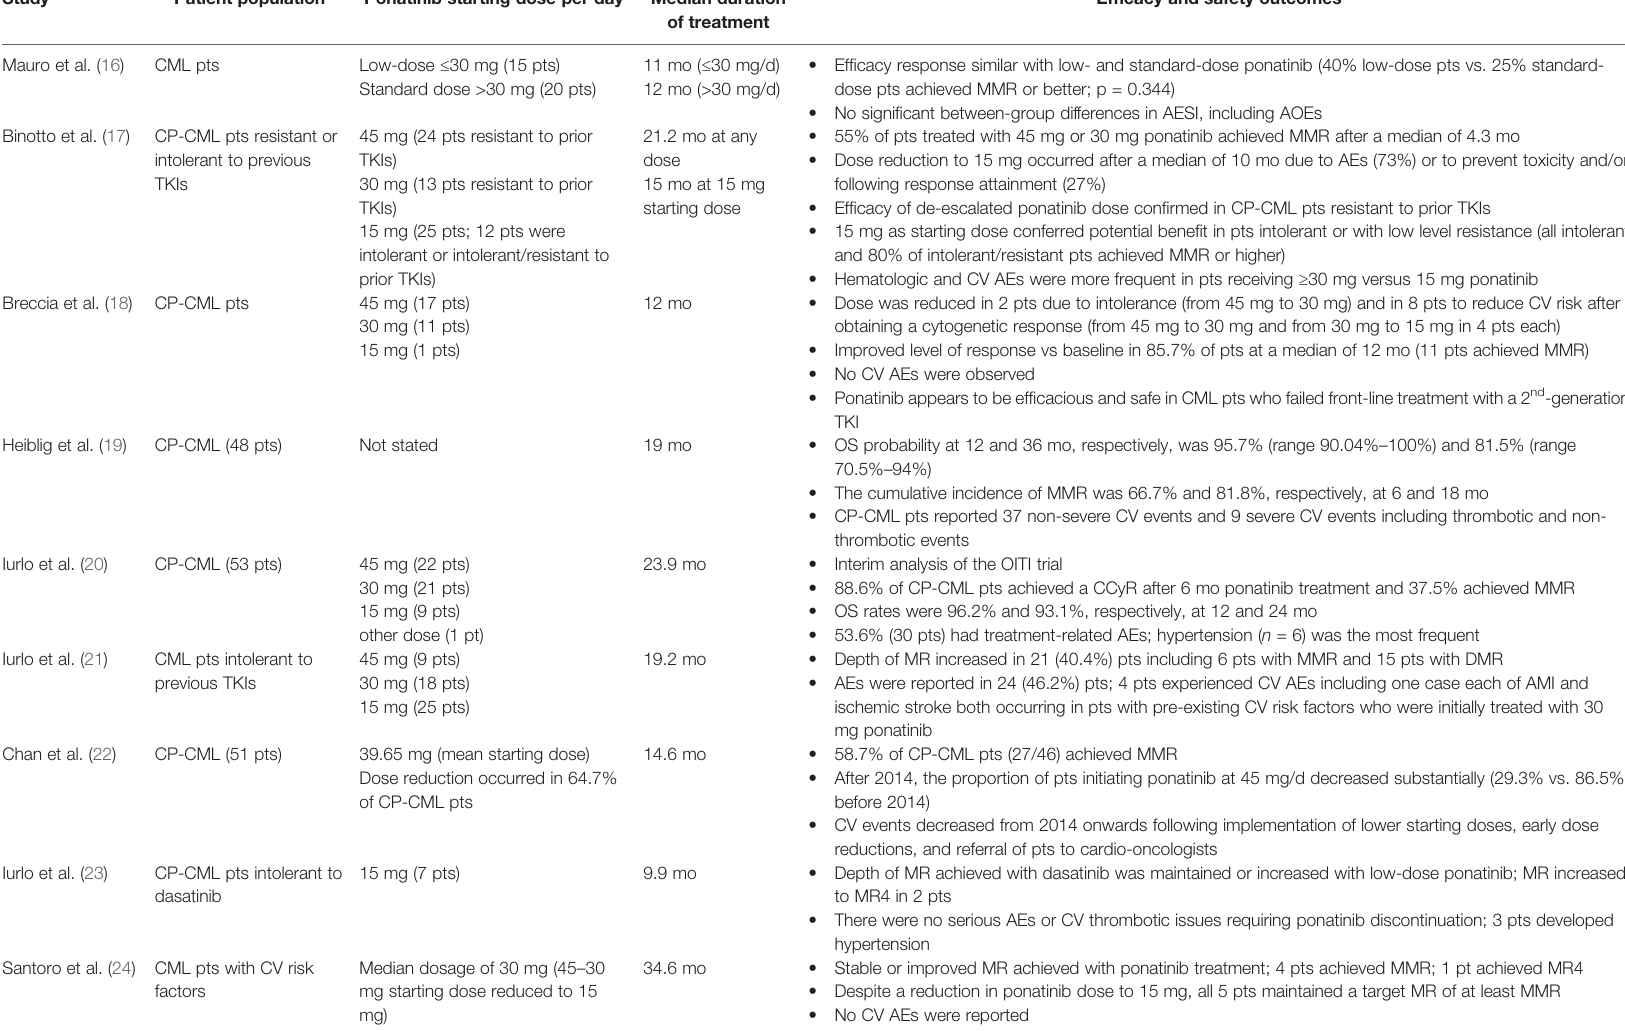
TABLE 1 | Low-dose ponatinib ef fi cacy and safety outcomes from real-life